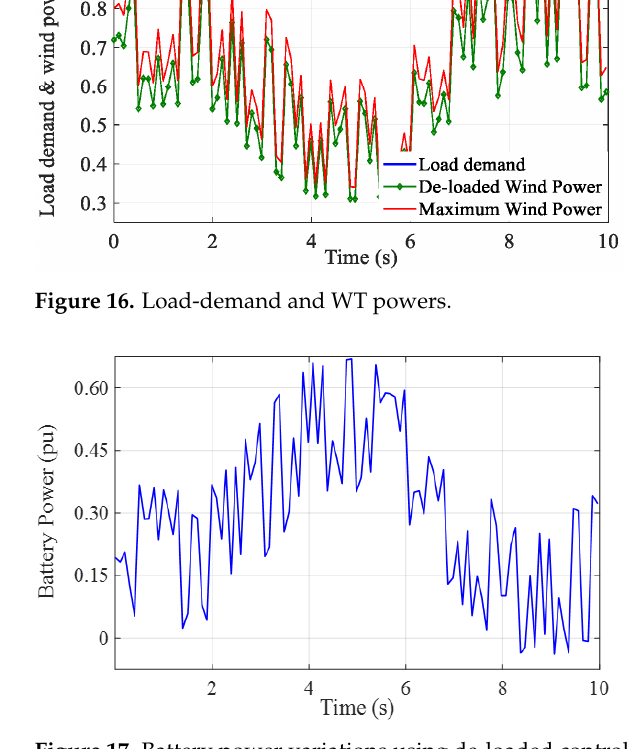
Figure 17. Battery power variations using de-loaded control.